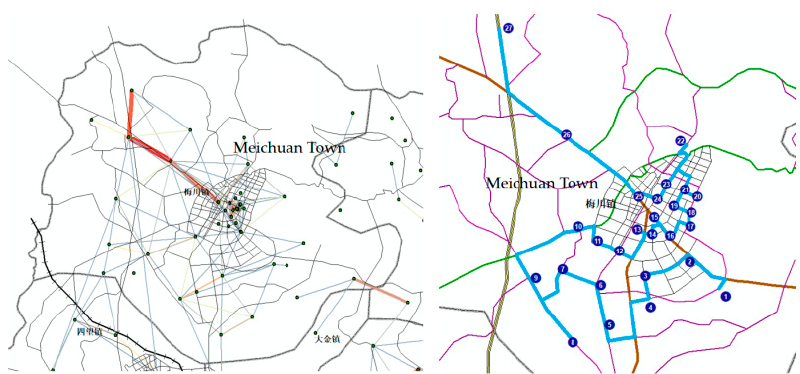
Figure 19. Travel OD distribution and bus route design in Meichuan Town.